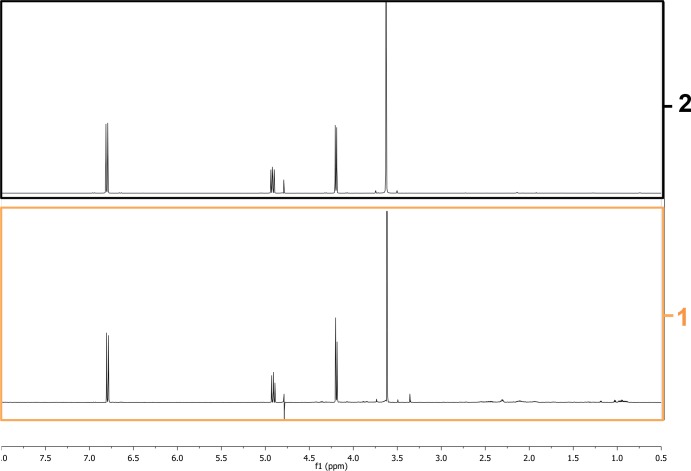
1H NMR spectra of F37 and synthetic AMB in D2O.The 1H NMR spectra of AMB localized in F37 (1) is similar of that of synthetic AMB, demonstrating that F37 contains AMB.